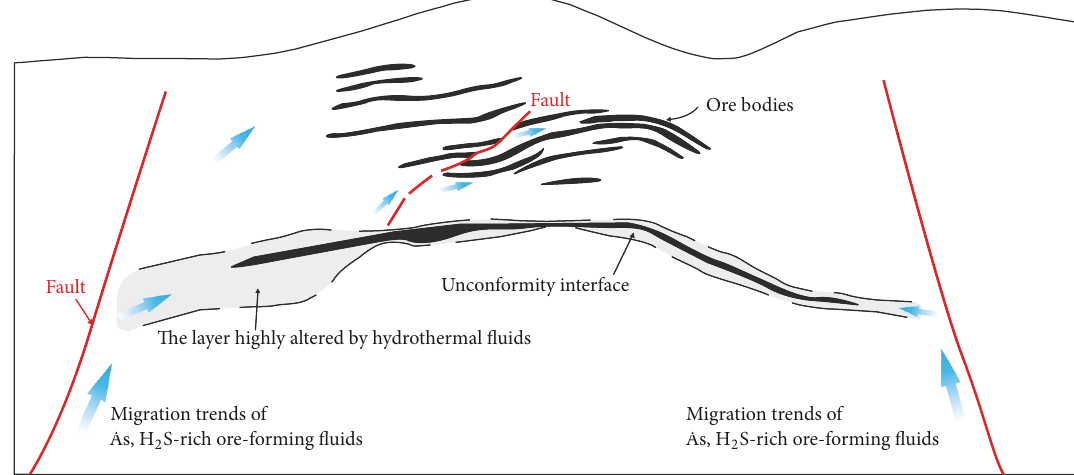
Figure 9: Sketch map showing the ore-forming processes in the Bojitian Carlin-type Au